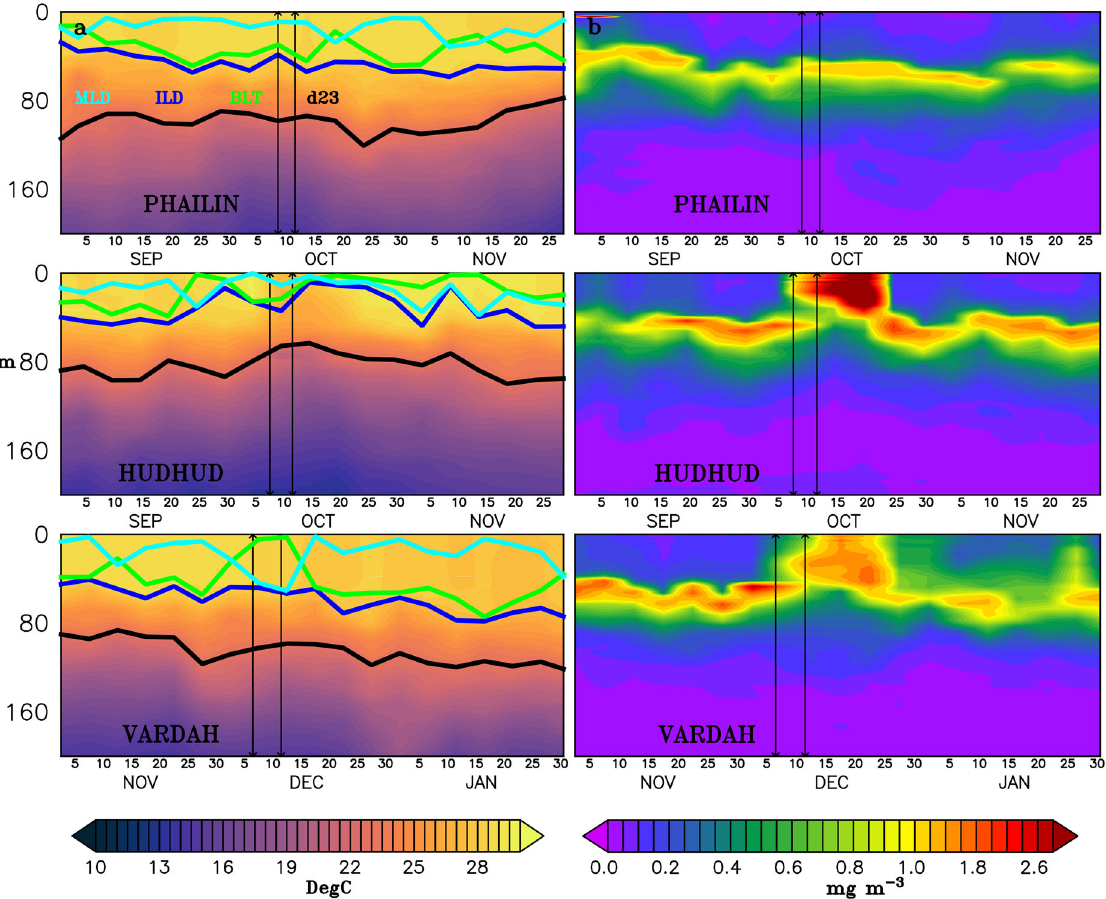
Fig. 4 Bio-Argo measurements. Temporal evolution (right panel) of depth-time section up to 200 m of temperature of some selected cyclones in the BoB. The MLD (cyan), ILD (blue), BLT (green), and D23 (black) are also indicated in the fi gure. The vertical black lines indicate the cyclone period. The subsurface Chl-a concentration (left panel) up to 200 m for some selected cyclones in BoB. The vertical black lines indicate the cyclone